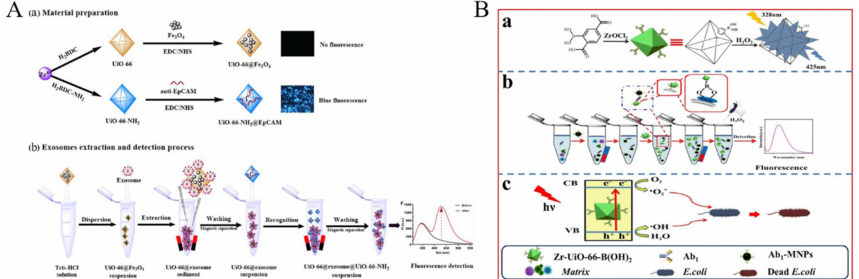
Figure 16. ( A ) Schematic illustration of the fluorescence detection method for cancer cell-derived exo- somes based on Zr-MOFs. Reproduced with permission [199]. Copyright 2022, Elsevier. ( B ) Schematic illustration of (a) preparation of Zr-UiO-66-B(OH) 2 and its fluorescence “turn-on” mechanism by H 2 O 2 ; (b) the immunoassay process for detection of E. coli through fluorescence signal; (c) Mechanism underlying the photocatalytic elimination of E. coli by the Zr-UiO-66-B(OH) 2 . Reproduced with permission [201]. Copyright 2021,